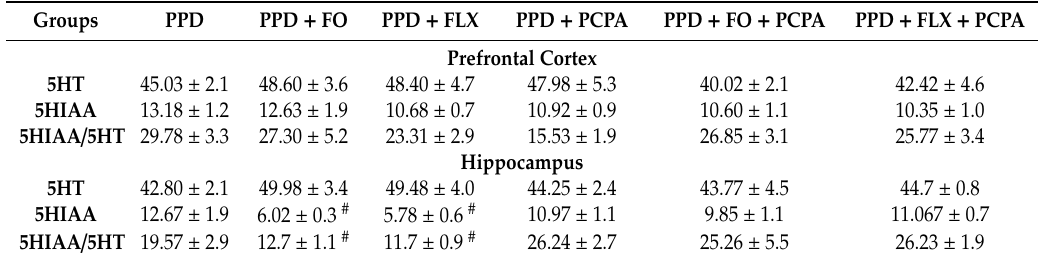
Table 2. Biochemical analysis of 5HT, 5-HIAA concentration (ng / mL) and 5HIAA / 5HT on PFC and hippocampus of PPD-like rats supplemented with FO. Tukey’s post hoc was used for the comparisons. Groups